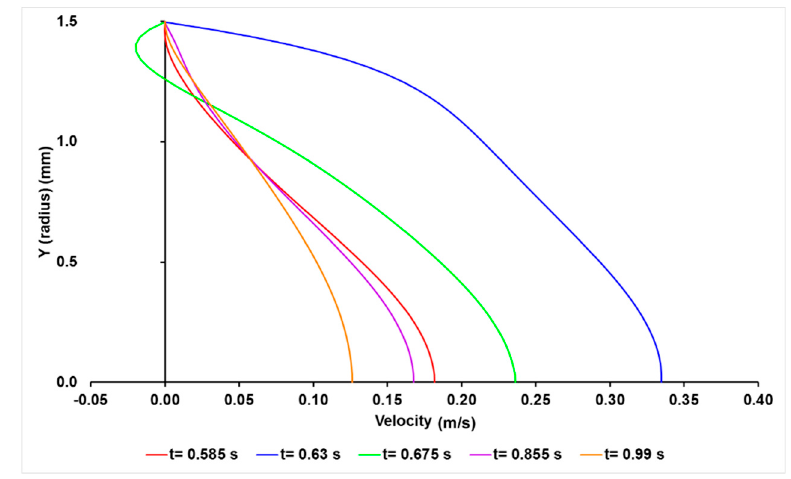
Figure 17. Local velocity profiles for selected time steps on phases I and II at the middle (x = 0 mm) of the vascular graft region.